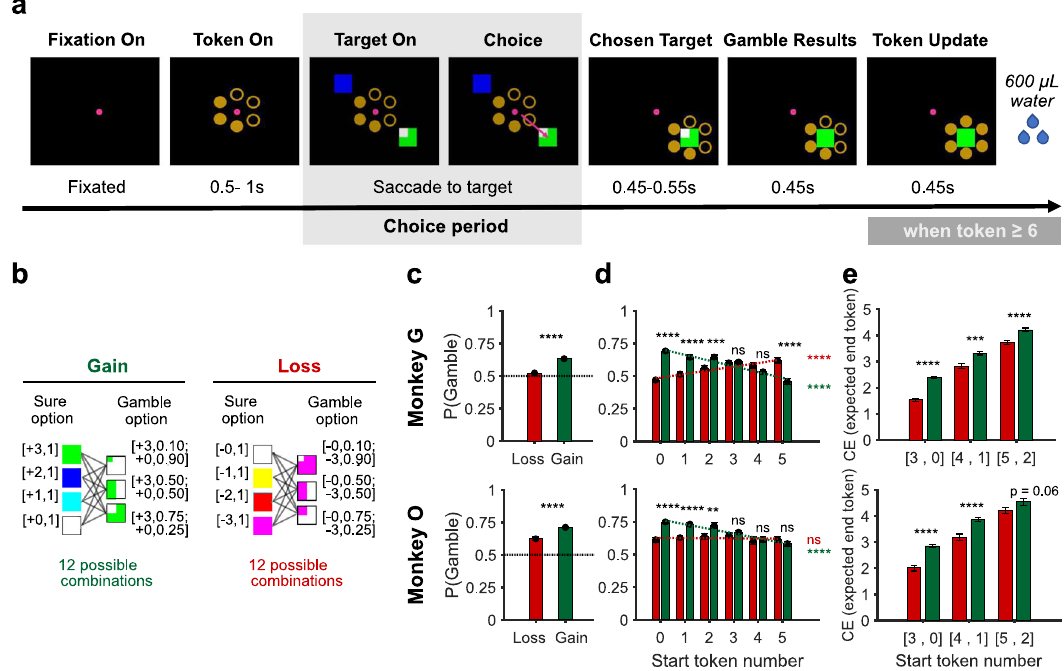
Fig. 1 Behavioral performance of monkeys in the token-based gambling task. a Task design. The monkey was informed about the currently owned token number (indicated by the fi lled dots surrounding the fi xation spot) and chooses a sure or gamble option by making a saccade to the desired reward option. After the outcome was revealed, the token number was updated. The monkey was rewarded whenever it collected six tokens or more at the end of the trial. Shadowed area indicates the choice period, during which the neuronal activity was analyzed. b Reward option set. Each option was de fi ned by the number of tokens gained or lost (indicated by color) and the probability of each outcome (indicated by the portion of colored area). The outcomes and probabilities are indicated in brackets next to each sure and gamble option. The trials were divided into gain and loss conditions. Each gamble option was paired against all sure options ranging from best ( + 3 for the gain and 0 for the loss context) to worst (0 for the gain and − 3 for the loss context) possible gamble outcomes, resulting in 24 combinations. See “ Methods ” section for details. c The probability of monkey choosing the gamble option in gain and loss contexts across all sessions. One-sided paired t -test. d The probability of monkey choosing the gamble option as a function of gain/loss context and start token number. Pair- wise comparison for each start token level: one-sided paired t -test; black statistical markers. Trend across start token level: regression; green and red statistical markers. e Subjective value of gamble-pairs, measured by their certainty equivalent (CE), that resulted in the same distribution of expected end tokens, but had different start token number and thus represented gain (green) or loss (red) of tokens. one-sided permutation test. c – e n = 37 sessions for both monkey G and monkey O. Data in the gain and loss context are colored in green and red, respectively. Data are presented as mean values ± SEM. ns not statistically signi fi cant (i.e., p > 0.05), ** p < 10 − 2 , *** p < 10 − 3 , **** p < 10 − 4